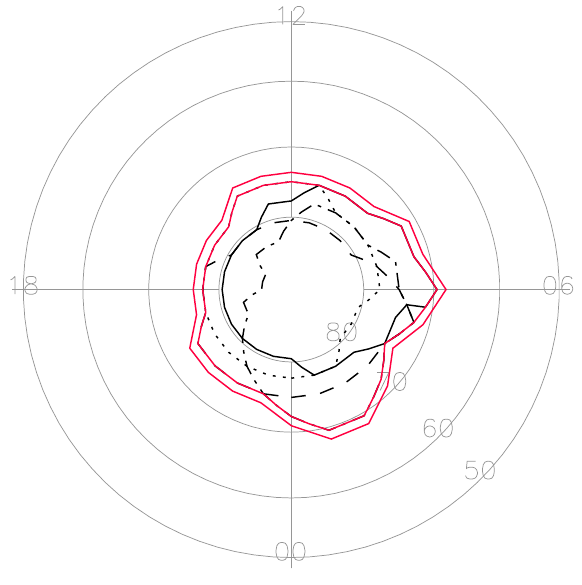
Fig. A1. Example estimation of the OCFLB for NH Summer Solstice 2004 (21 June, DOY=173) B z =− 1.8nT, B y = 1.9nT and P dyn = 1.5nPa. Estimated boundaries are shown for 00:00UT (solid), 06:00UT (dotted), 12:00UT (dashed) and 18:00UT (dash- dot) with the final estimate being that which encompasses all four estimates, i.e., the double red line. Coordinates are geomagnetic latitude and magnetic local time